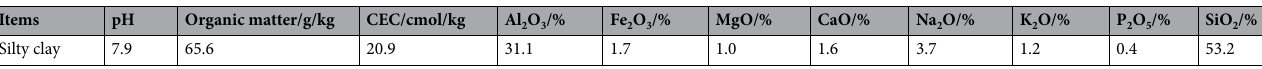
Table 4. Soil chemical composition.